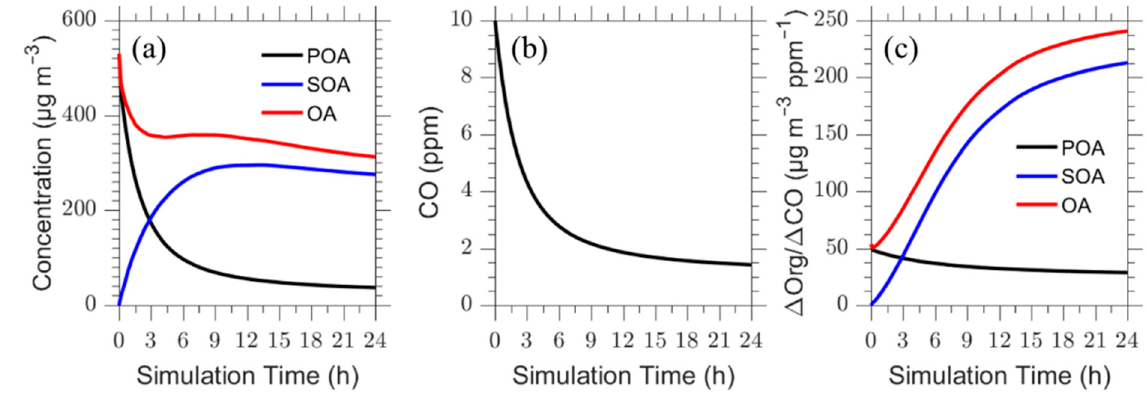
Figure 2. Time series of ( a ) organic aerosol concentration; ( b ) CO concentration; ( c ) rate difference organic aerosol concentration to the difference of CO concentration at the plume centerline level for the base case. The POA concentration is in black, SOA concentration in blue and the red line is the total OA.